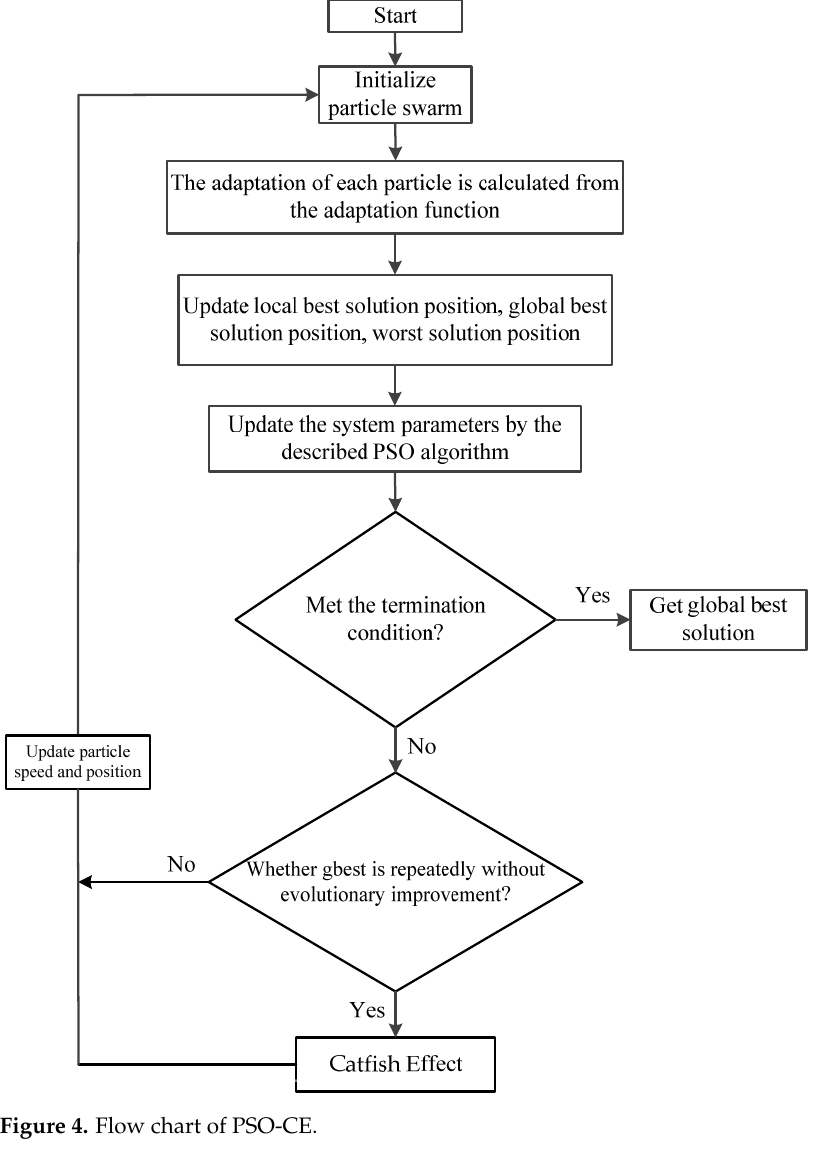
Figure 4. Flow chart of